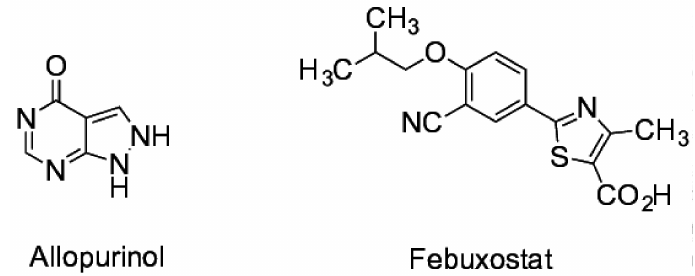
Figure 1. Chemical structures of allopurinol and febuxostat